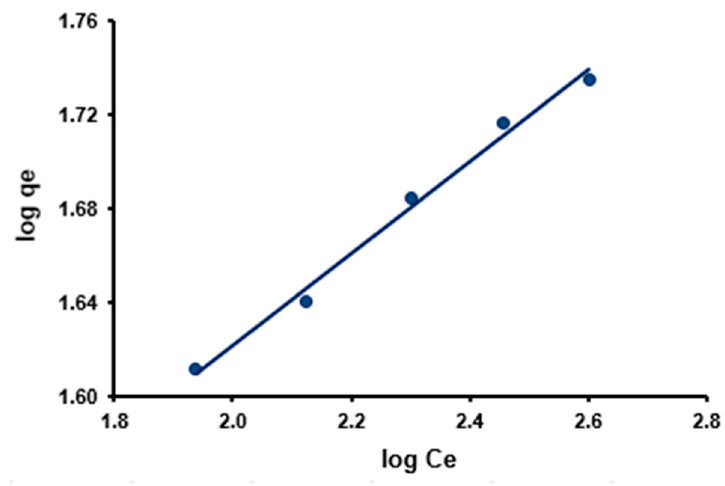
Figure 4. Freundlich isotherm for niobium sorption with Purolite A-100 anionite.